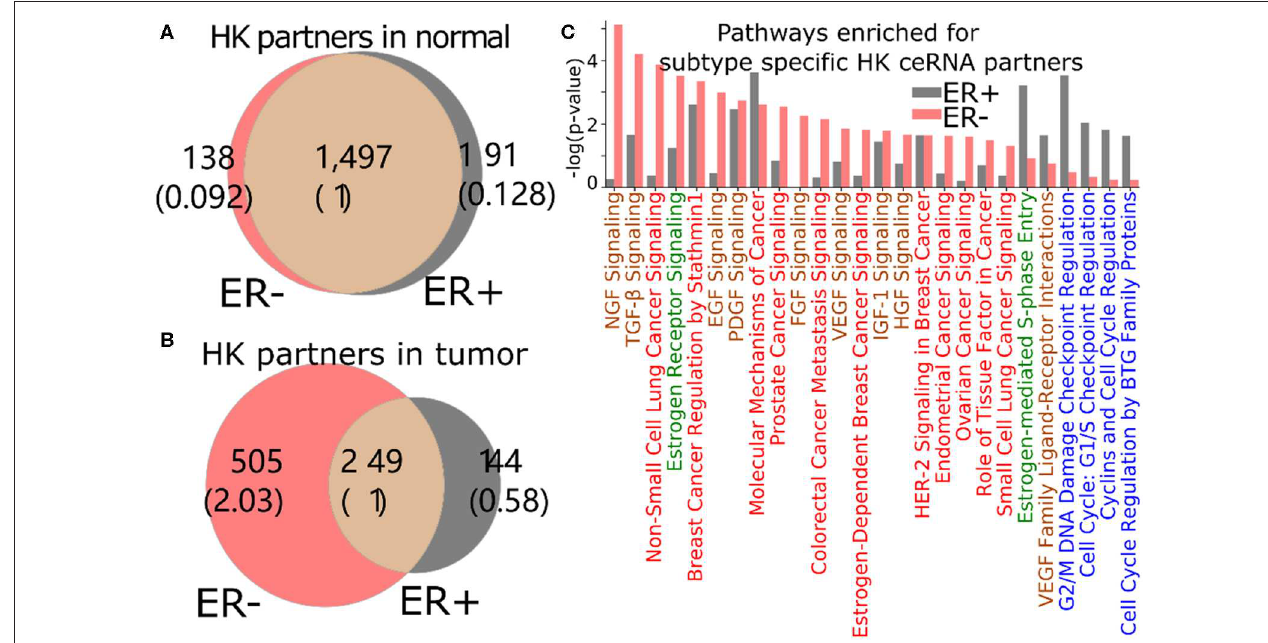
FIGURE 5 | 3 ′ US disrupts the ceRNA relationship of HK genes for ER- specific growth. Number of HK ceRNA partners unique and common to ER- and ER (A) and tumor (B) ceRNA networks. The numbers in parentheses are normalized to the number of genes shared between tumor and normal. (C) IPA canonical pathways significantly ( P < 0.01) enriched for ER and ER- specific HK ceRNA partners. The pathways are color-coded by keyword: “cancer” in red, “GF” in brown, + “estrogen” in green, and “cell cycle” in